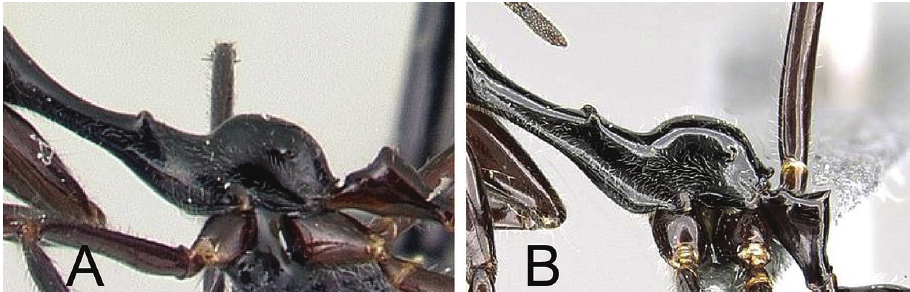
Figure 15. A Variant 1, a typical C. karaha . CASENT0067555 B Variant 2 from the north.